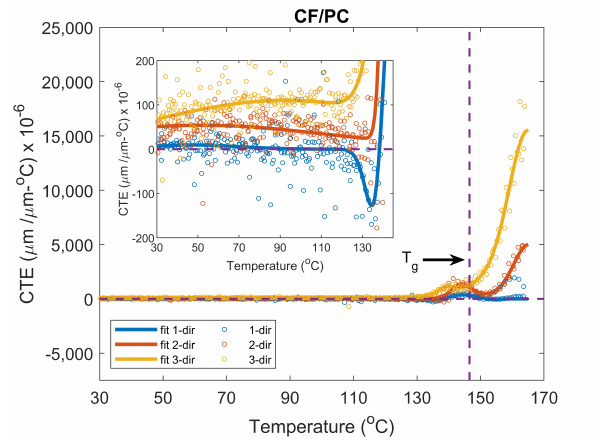
Figure 11. CTE comparison of experimental data and fitting function. Table 9. Gaussian fitting for CF/PC centered on the bead. Fitting